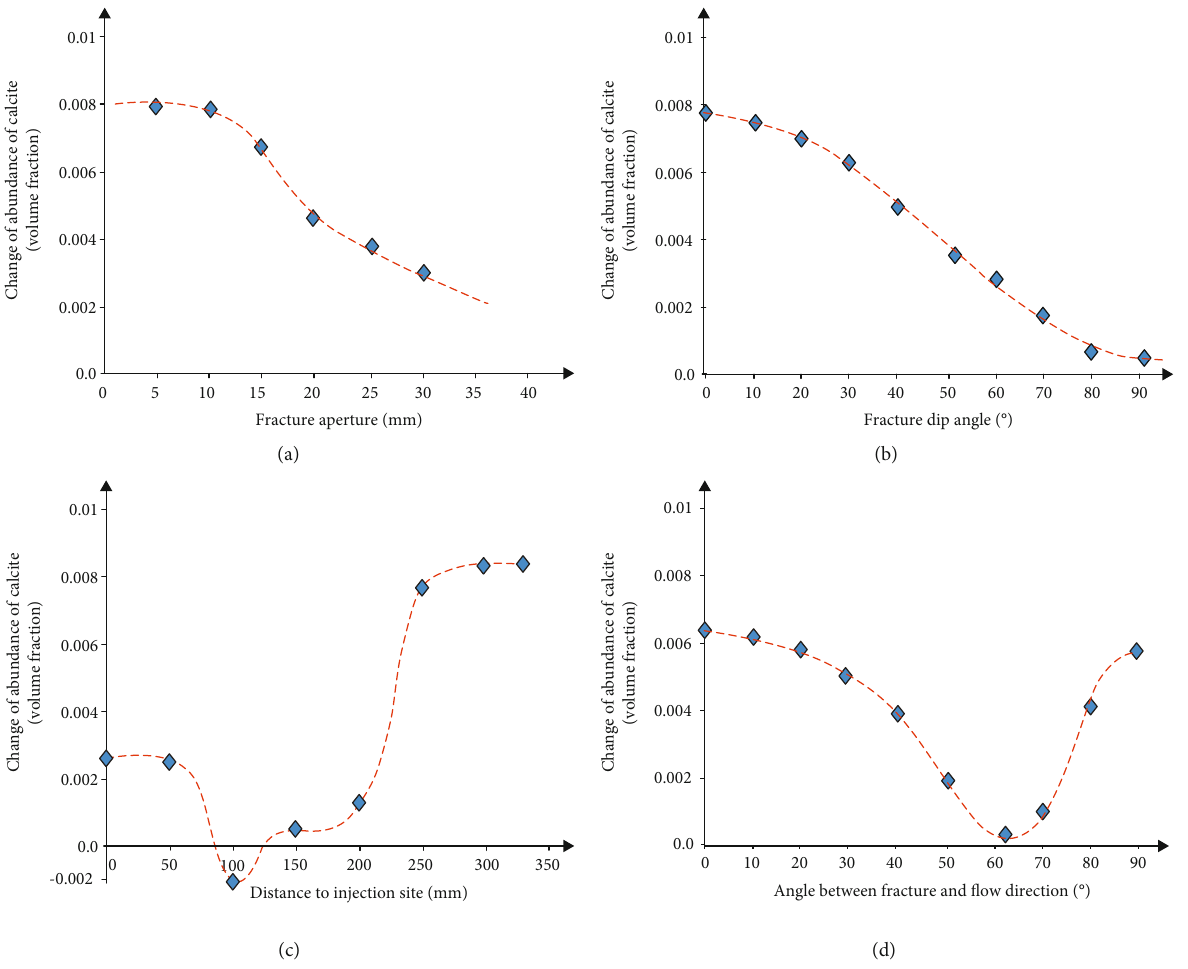
Figure 10: Typical model curves that characterize the behaviour of precipitation/dissolution when prescribed geo fl uid fl ow within various fracture networks. (a) Change curve of calcite abundance along with variable aperture of fractures (coordinates can be dimensionless); (b) change curve along with variable dip angle; (d) change curve along with variable distance; (c) change curve along with variable angle (coordinates can be dimensionless); (d) change curve along with variable